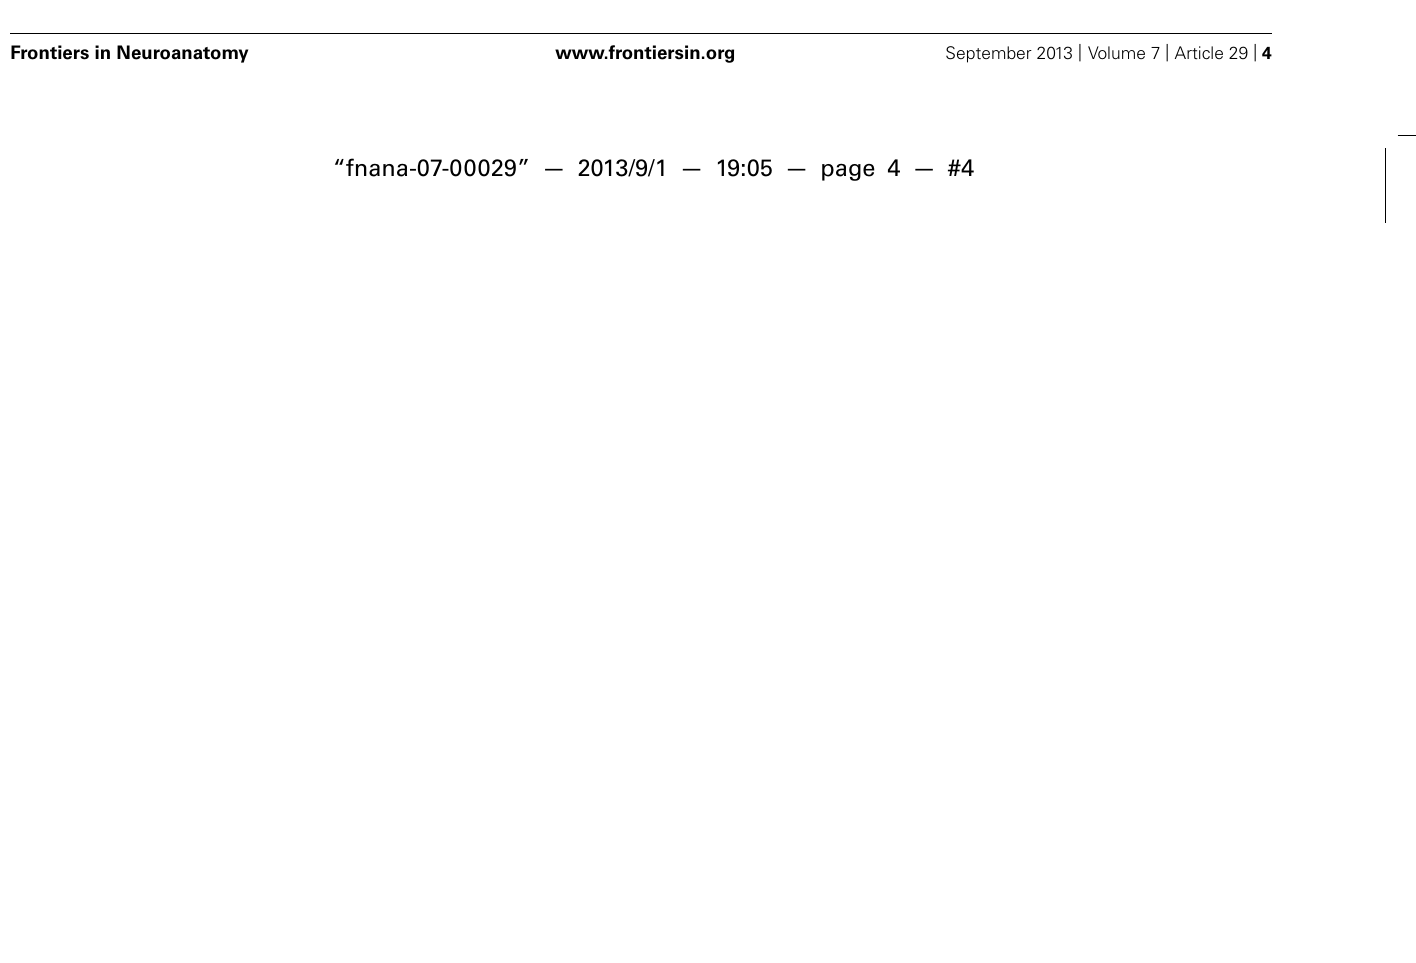
consistent with Gli3 as a regulator of dorsal neural tube cell